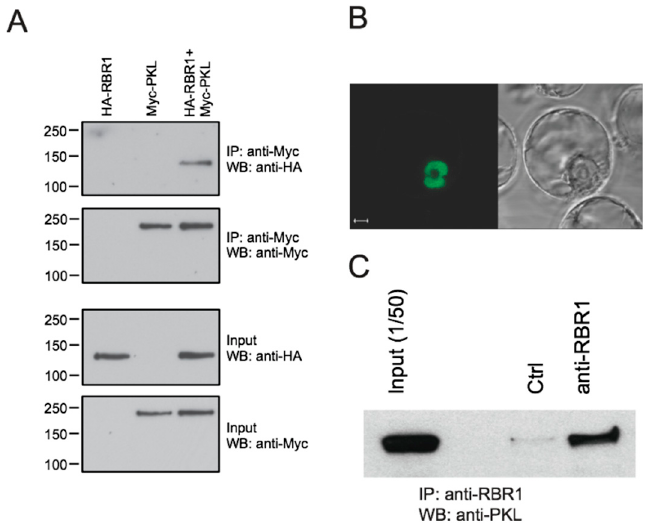
Figure 1. Chromatin remodeling protein PICKLE (PKL) interacts with RETINOBLASTOMA-RELATED 1 (RBR1) in vivo. ( A ) Protoplasts were transfected with 35S::HA-RBR1 (HA-RBR1) and 35S::myc-PKL (Myc-PKL) constructs, and protein extracts from transformed protoplasts were im- munoprecipitated with anti-myc antibodies. Immunocomplexes and input proteins were analyzed on protein gel blots using anti-HA or anti-myc antibodies, respectively. ( B ) Confocal microscopic image of the subcellular localization of the RBR1/PKL complex by bimolecular fluorescence comple- mentation (BiFC) assays. Coexpression of 35S::YFPN-RBR1 (RBR1) and 35S::YFPC-fPKL (fPKL) in suspension derived Arabidopsis protoplasts. Bar = 5 µ m. ( C ) Co-immunoprecipitation (CoIP) assay